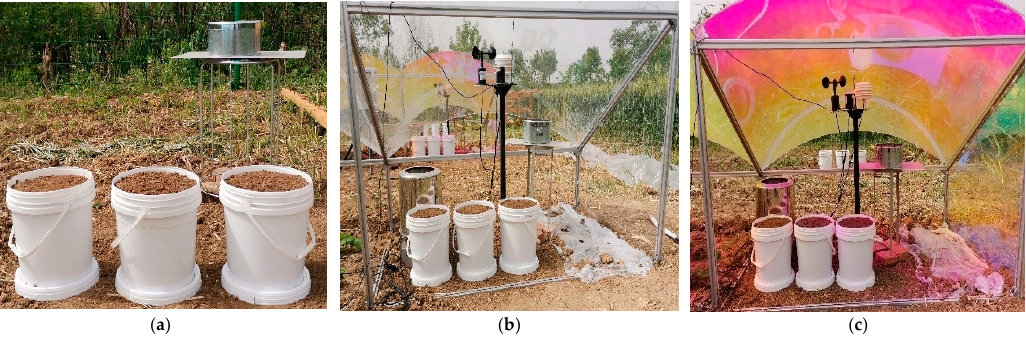
Figure 2. The evaporation containers filled with dried soil are put into a 10 cm water depth tank. Figure 3. The design of three experiment treatments, evaporation containers and pans evaporation placed ( a ) in the open-air, ( b ) under a glass shed, and ( c ) under a glass-shed covered with multilayer film.